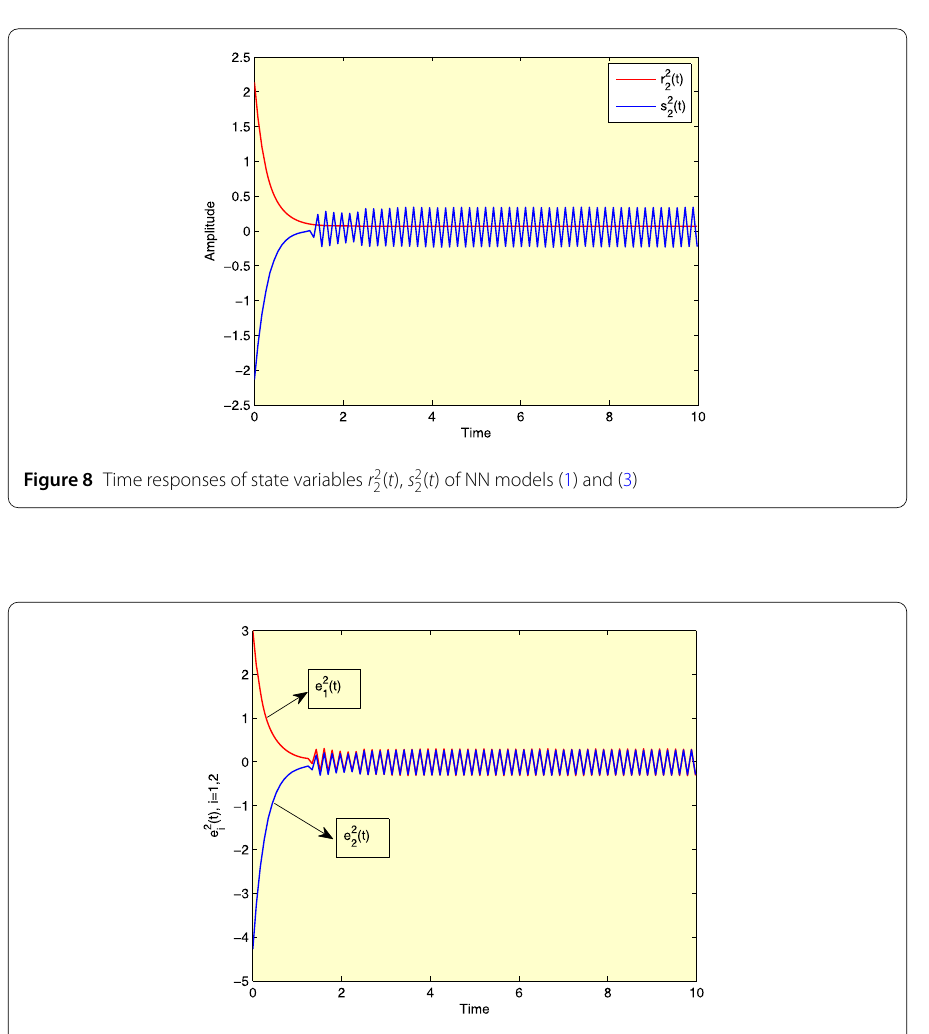
Figure 9 Synchronization curves of state variables e 2 1 ( t ), e 2 2 ( t ) of NN model (10) under controller